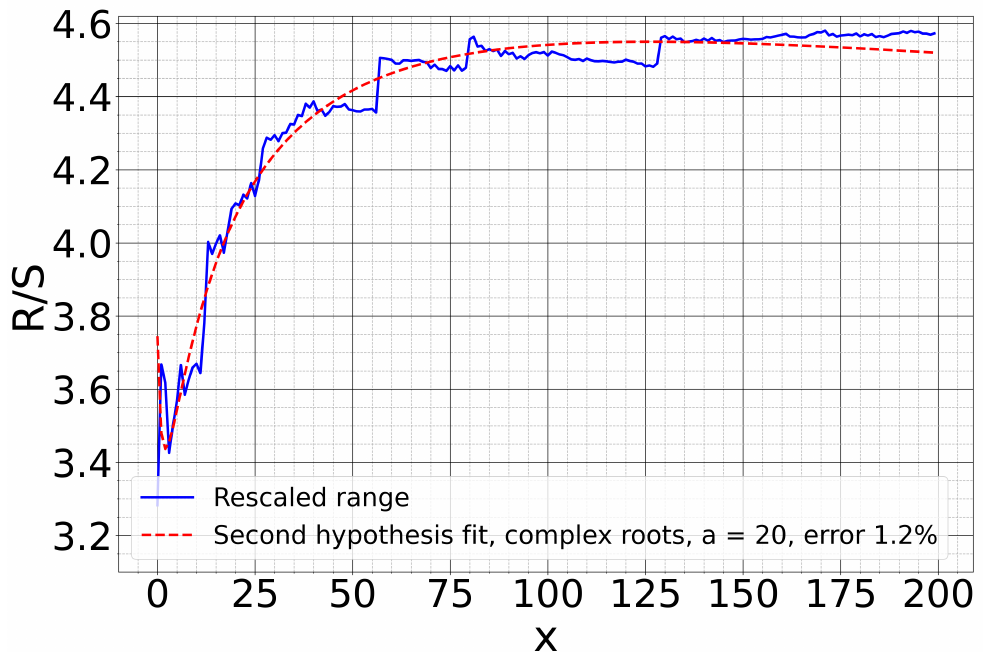
Figure 3. Fitting of NI USRP noise phase R/S (Hypothesis 2): complex H -values. Third, we recorded the noise of Audio-Technica AT2020USB+ condenser microphone. It has 16-bit ADC and allows performing stereo recording; therefore, there are two signals: left channel and right channel. After testing the third hypothesis on this data, we found that the differential noise signal is the most suitable one. That is, we subtract the right channel noise from the left-channel one and analyze the difference. Figure 4 demonstrates fitting using the third hypothesis.